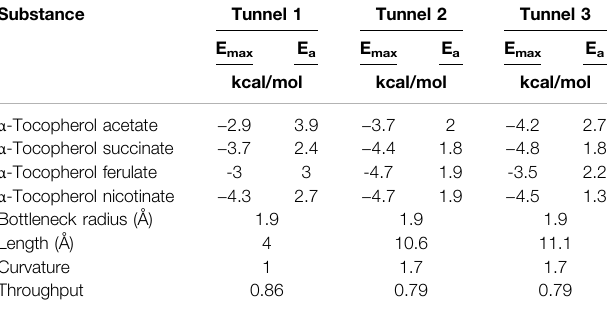
TABLE 5 | Characteristics related to CALB tunnels with more probability to realize the transport of